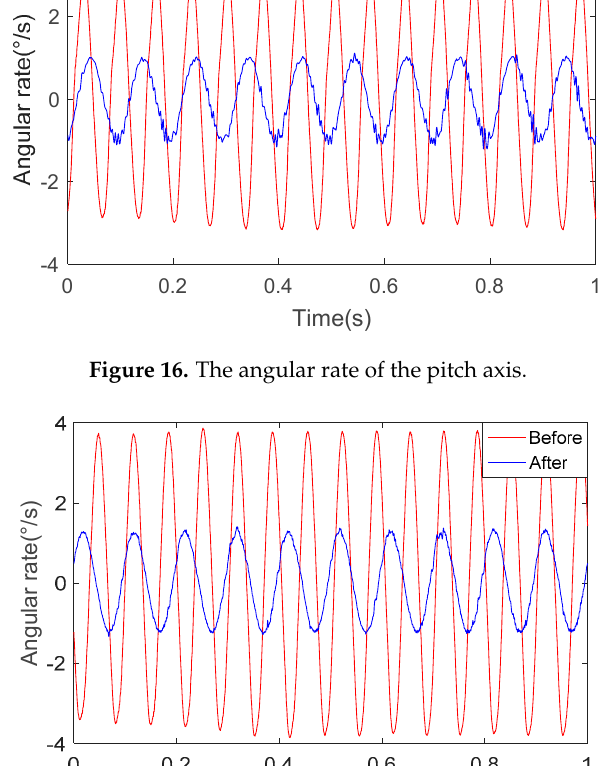
Figure 17. The angular rate of the yaw axis.